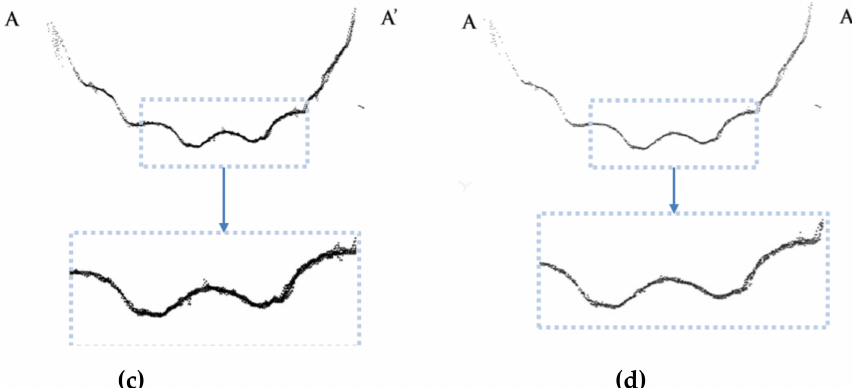
Figure 4. E ff ect of statistical outlier removal (SOR) and radius outlier removal (ROR) filters on a point cloud on the surface of a Roman column: ( a ) Point cloud with outliers in areas marked with dashed lines in yellow; ( b ) point cloud after applying the SOR filter, section AA is marked with a red line; ( c ) point cloud of section AA after applying the SOR filter; and ( d ) point cloud of section AA after the application of the SOR and ROR filters, with a better definition of the contour of the column